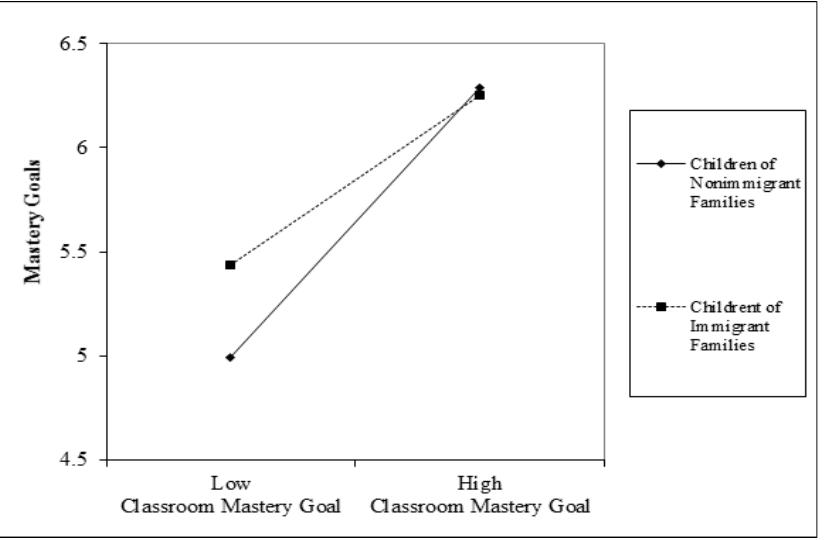
Figure 2 . Students’ own mastery goals as a function of immigration groups and classroom mastery